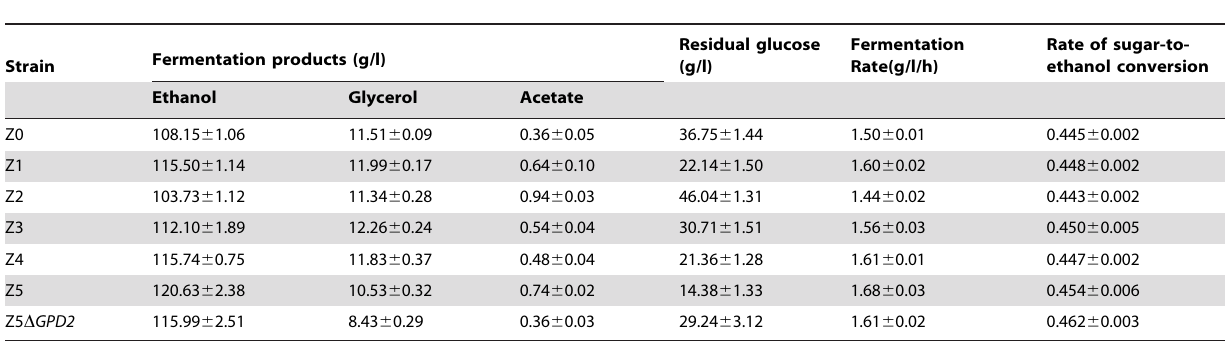
Table 1. Fermentation performance comparisons between industry strains under VHG conditions.